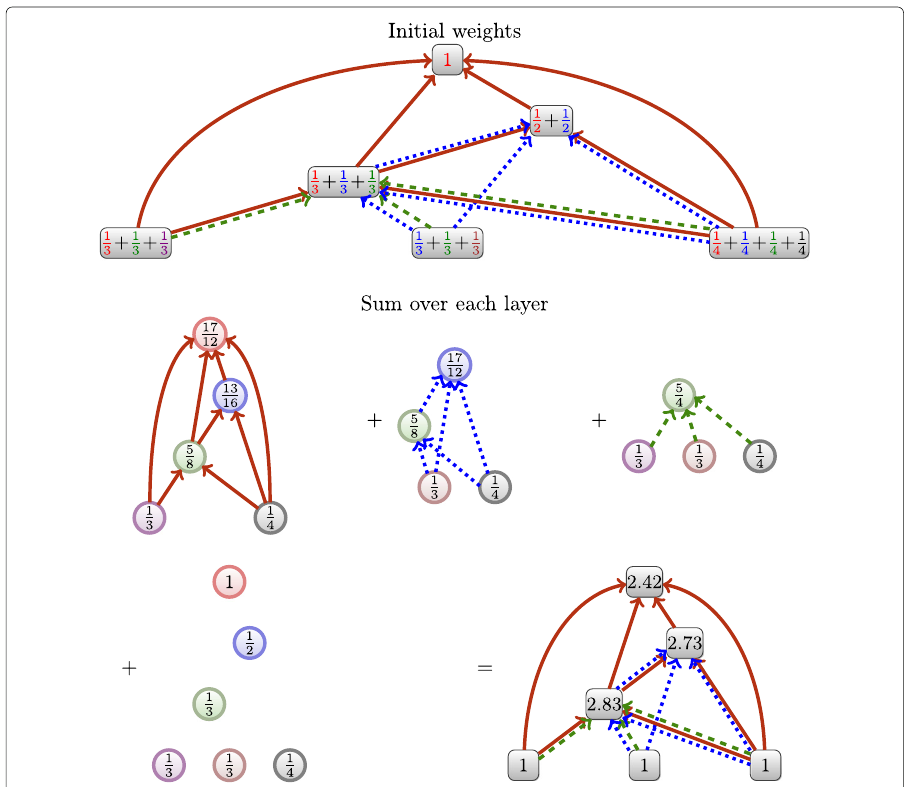
Fig. 10 Illustration of the sum flow: we individually initialize weights to each node, depending on the number of layers each belongs to (including its own). We then compute the ascending flow for each layer (including individual), and sum the obtained